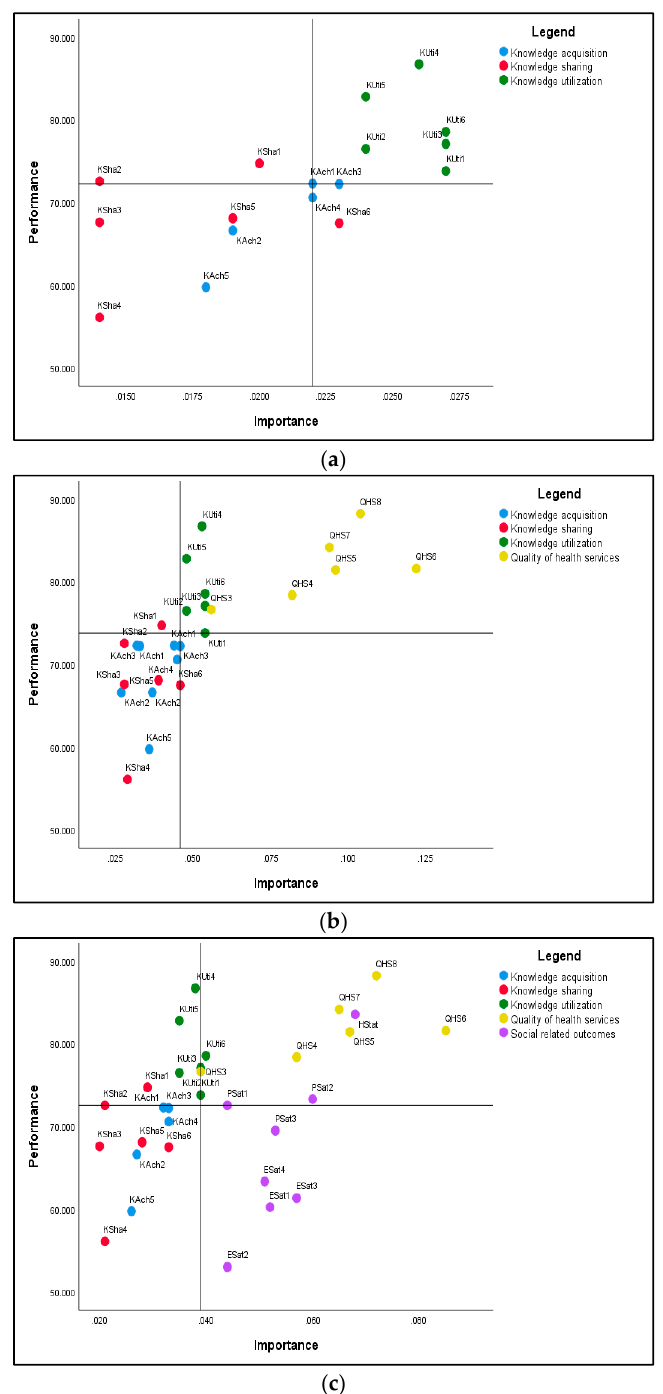
Figure 3. Importance-Performance Matrix Analysis (IPMA) for the target constructs: ( a ) quality of healthcare, ( b ) social outcomes, and ( c ) economic outcomes. Source: authors computation with SmartPls 3.2.7 (GmbH, Bönningstedt, Germany) [72] and IBM SPSS 25.0 (IBM Corp., Armonk, NY, USA) [55].